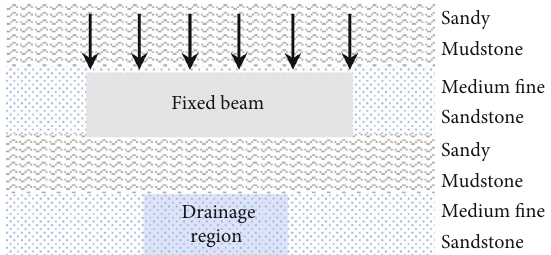
Figure 1: Fixed beam model of rock above drainage